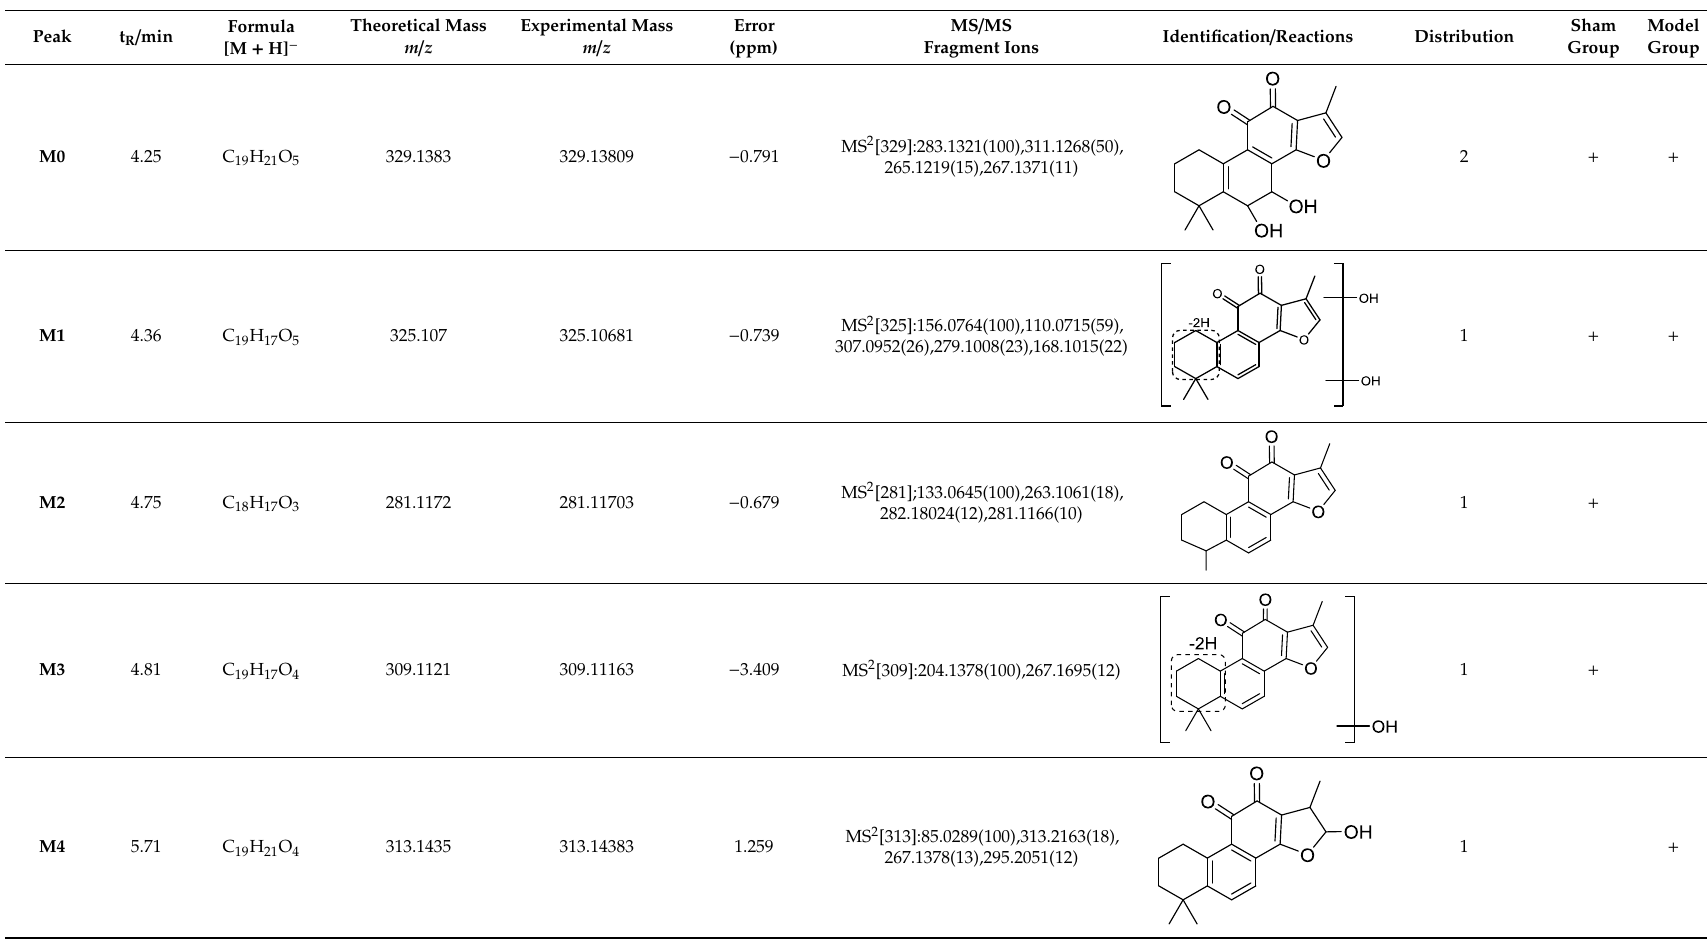
Table 1. Summary of tanshinone IIA metabolites by HPLC-Q-Exactive orbitrap.